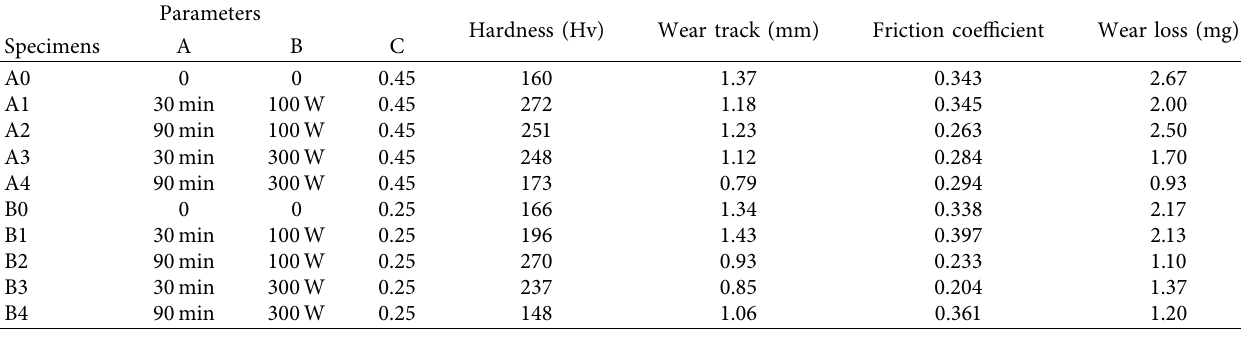
Table 6: Results of hardness and wear behavior.